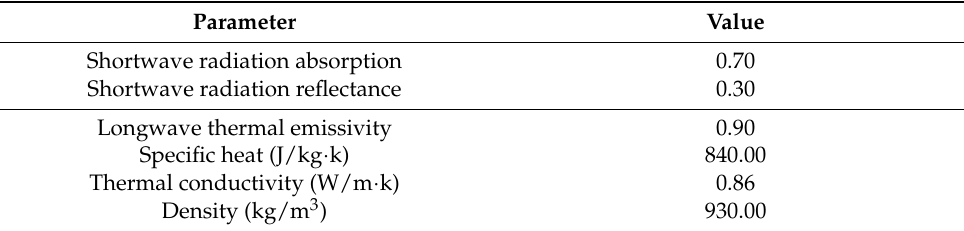
Table 1. Attributes of hollow concrete brick.